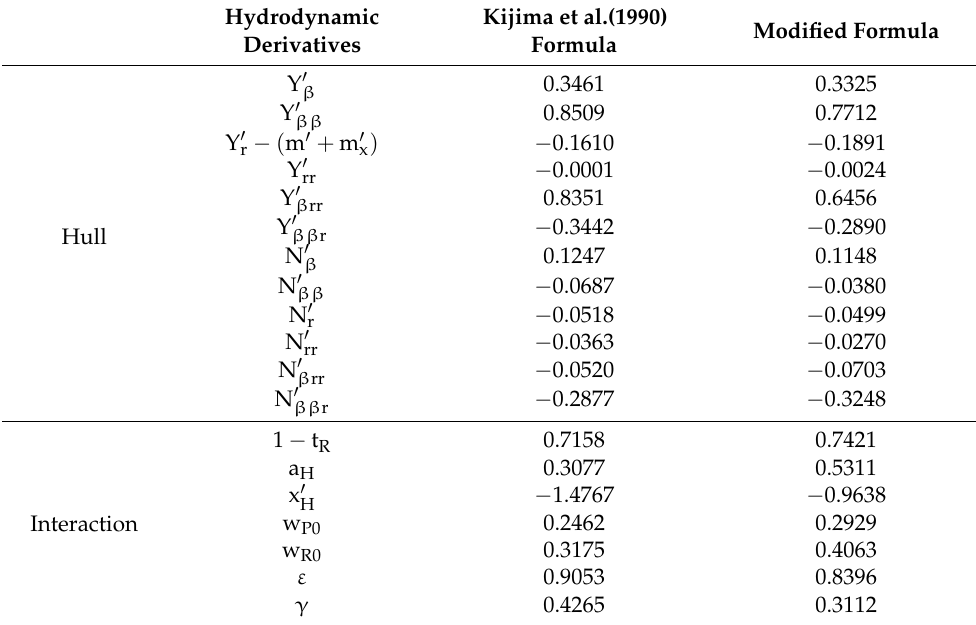
Table 5. The hydrodynamic derivatives of the target